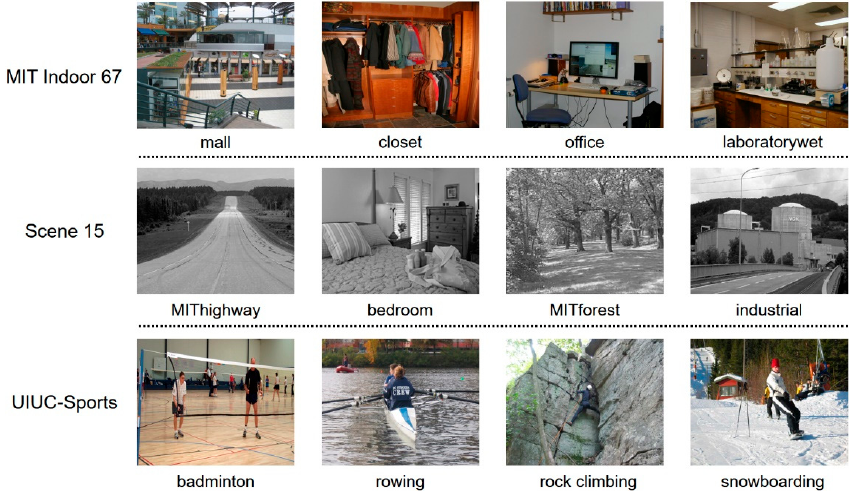
Figure 6. Some image examples of the three scene datasets.